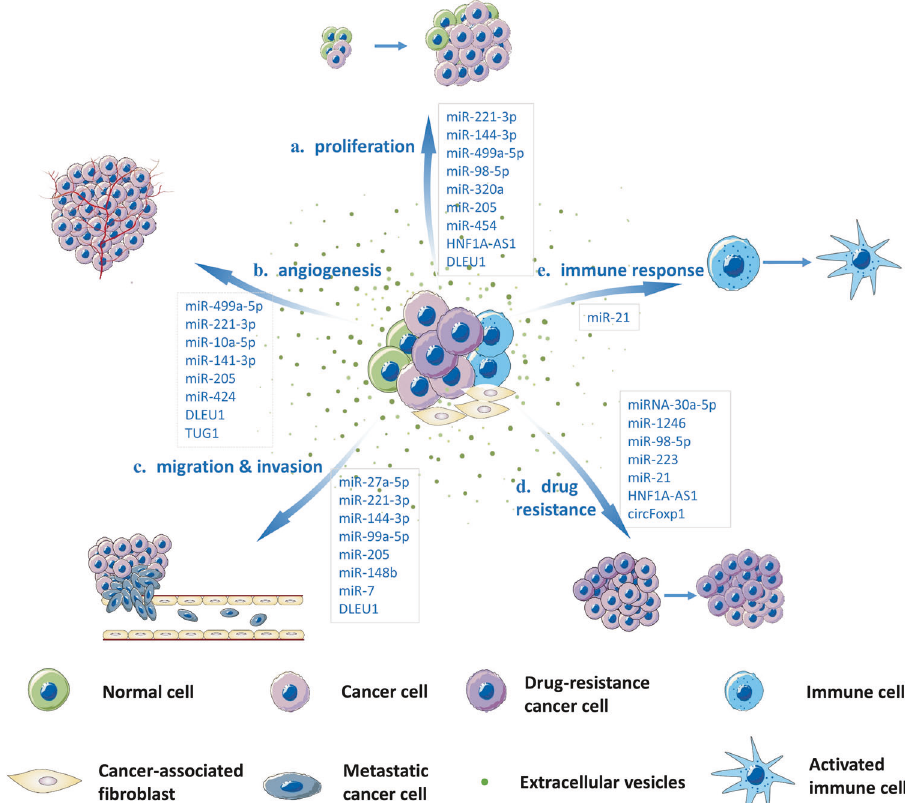
Fig. 3 A schematic representation of EV ncRNAs in regulation of gynecological malignancies. EV ncRNAs released by different cells regulate tumorigenesis and progression by promoting cancer cell proliferation, migration, invasion drug resistance, angiogenesis and immune